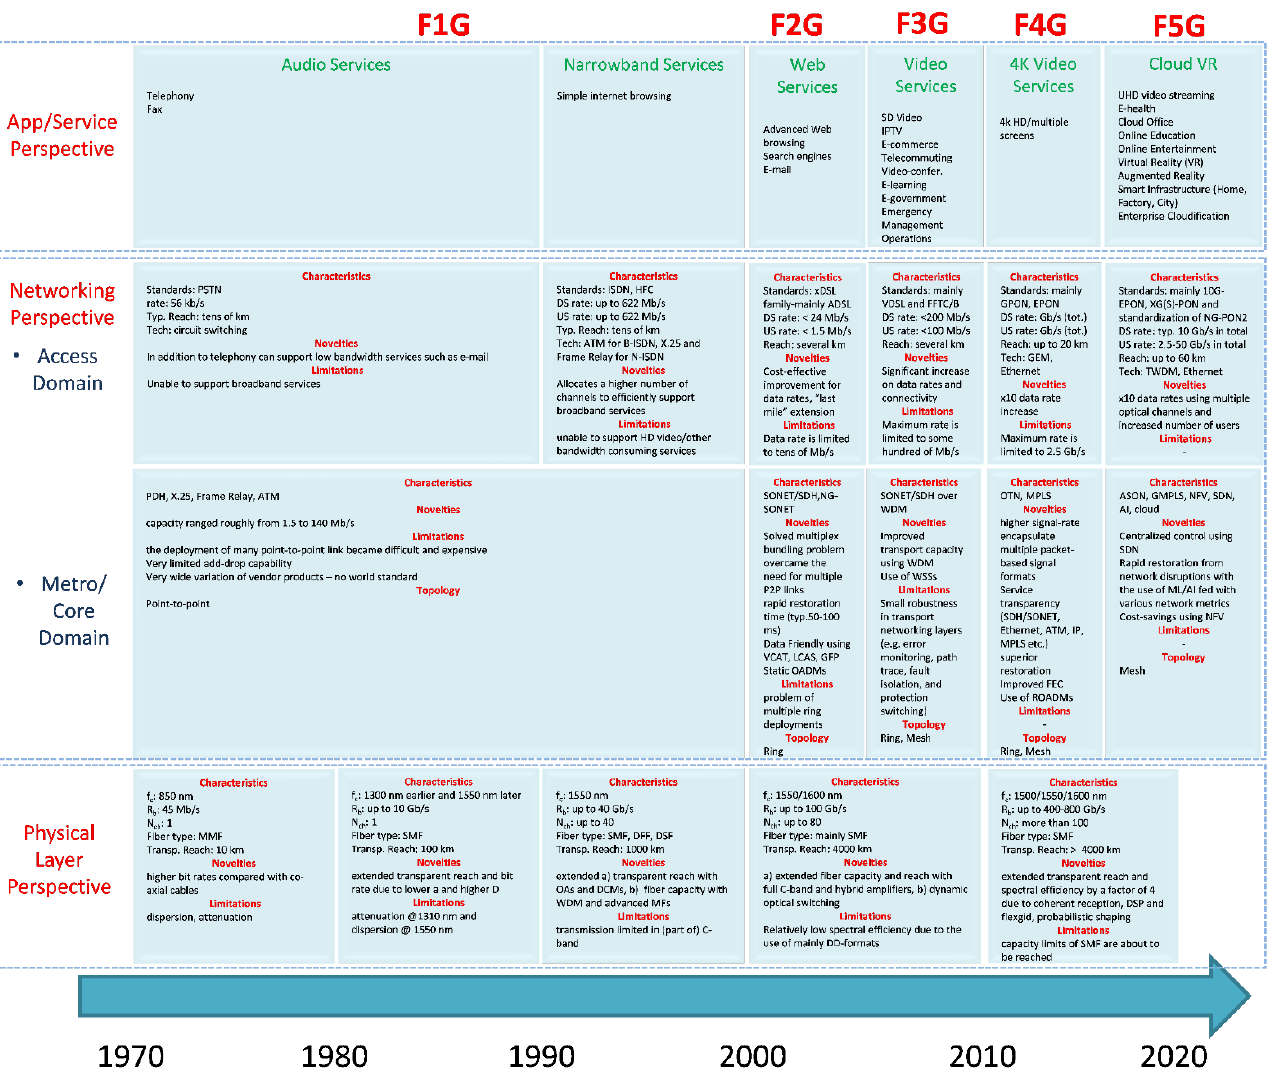
Figure 1. Layered analysis of the first five generations of fixed networks (F1G to F5G).